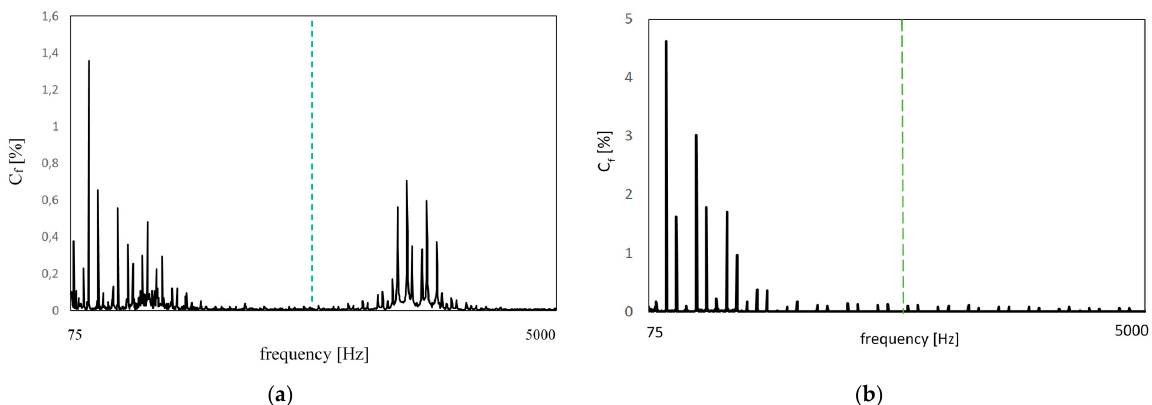
Figure 3. Voltage spectra at main bus bars of the maritime systems with AC PWM drives with an ‘Active Front End’ ( a ) and at main bus bars of the maritime systems with 6-pulse diode bridge ( b ). Note the distortions above the 50th order, marked by the green dashed line. C f is the content of higher frequency components in relation to fundamental voltage, both harmonics and interharmonics.